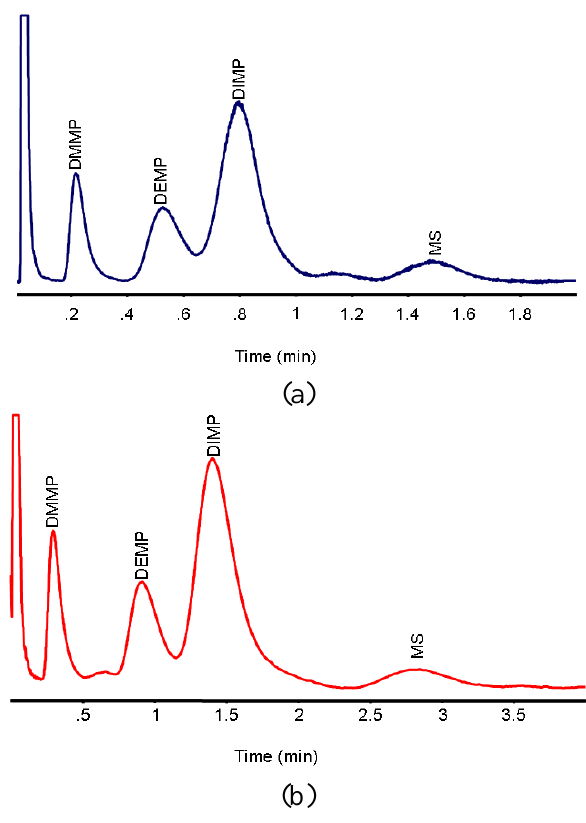
Figure 4. ( a ) Separation of four different CWA simulants dimethyl methyl phosphonate (DMMP), diethyl methyl phosphonate (DEMP), diisopropyl methyl phosphonate